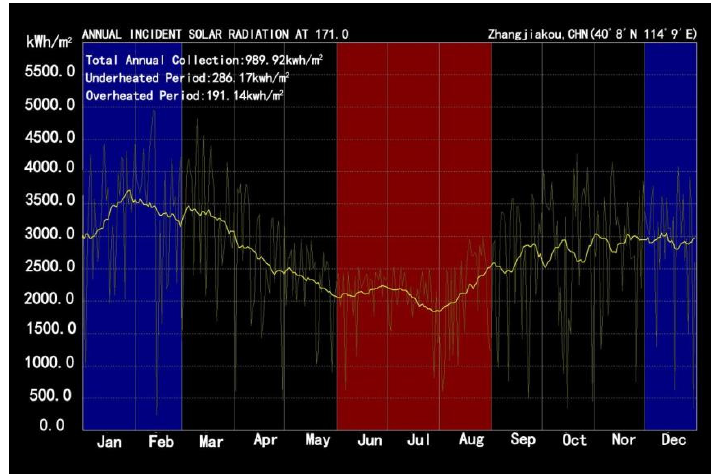
Figure 5. Annual solar radiation in Zhangjiakou City.